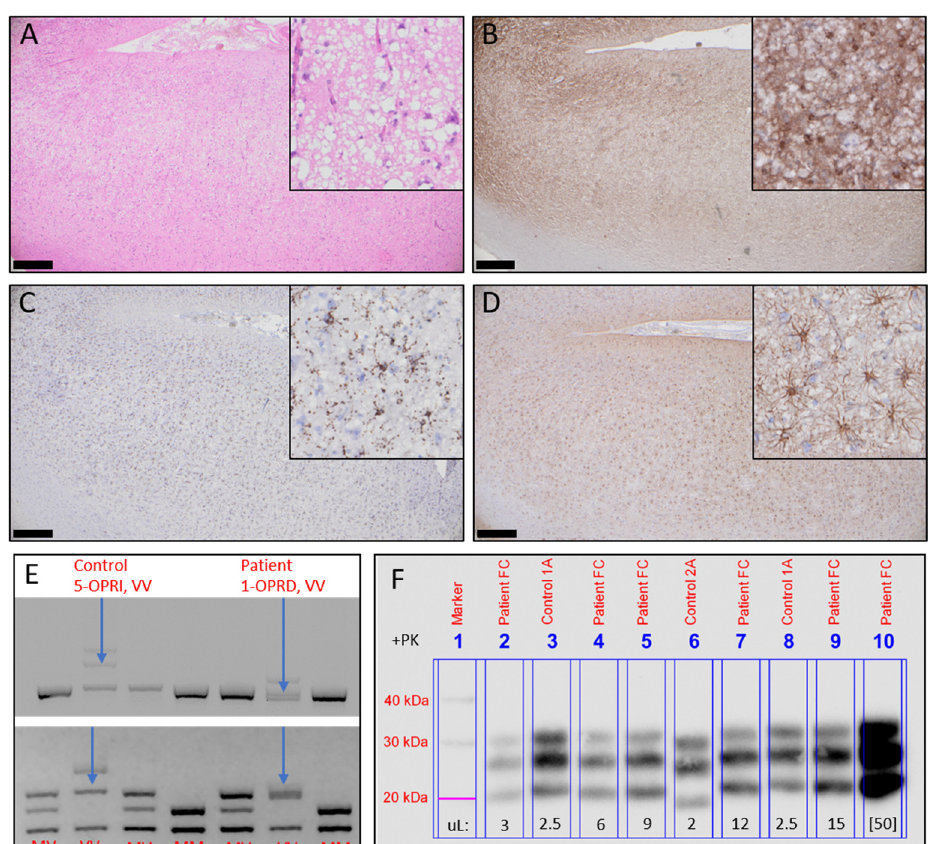
Figure 1. Neuropathology and molecular subtyping. ( A ) Severe cortical spongiosis (H&E staining). ( B ) Diffuse, cortical, protease K-resistant PrP Sc deposits (KG9 immunostaining). ( C ) Cortical microgliosis (CD68 immunostaining). ( D ) Cortical astrogliosis (GFAP immunostaining). Scale bars 500 µm; corner picture frames 200 µm ( E ) ( Top ) Electrophoretic visualization of DG2+I5 PCR products indicating wild type sequences, control sequence with 5-OPRI, and the current case with 1-OPRD. ( Bottom ) Presentation of the DG2+3 ′ SAL PCR product after digestion with XCell demonstrating the electrophoretic patterns of different codon 129 polymorphism variants and indicating that the patient is valine homozygous. ( F ) Western blot analysis of the patient’s brain homogenates showing PrP Sc type 1. Different volumes of the patient’s brain biopsy 10% w/v homogenate were treated with proteinase K, run by SDS-PAGE, and immunoblotted with the 3F4 antibody.